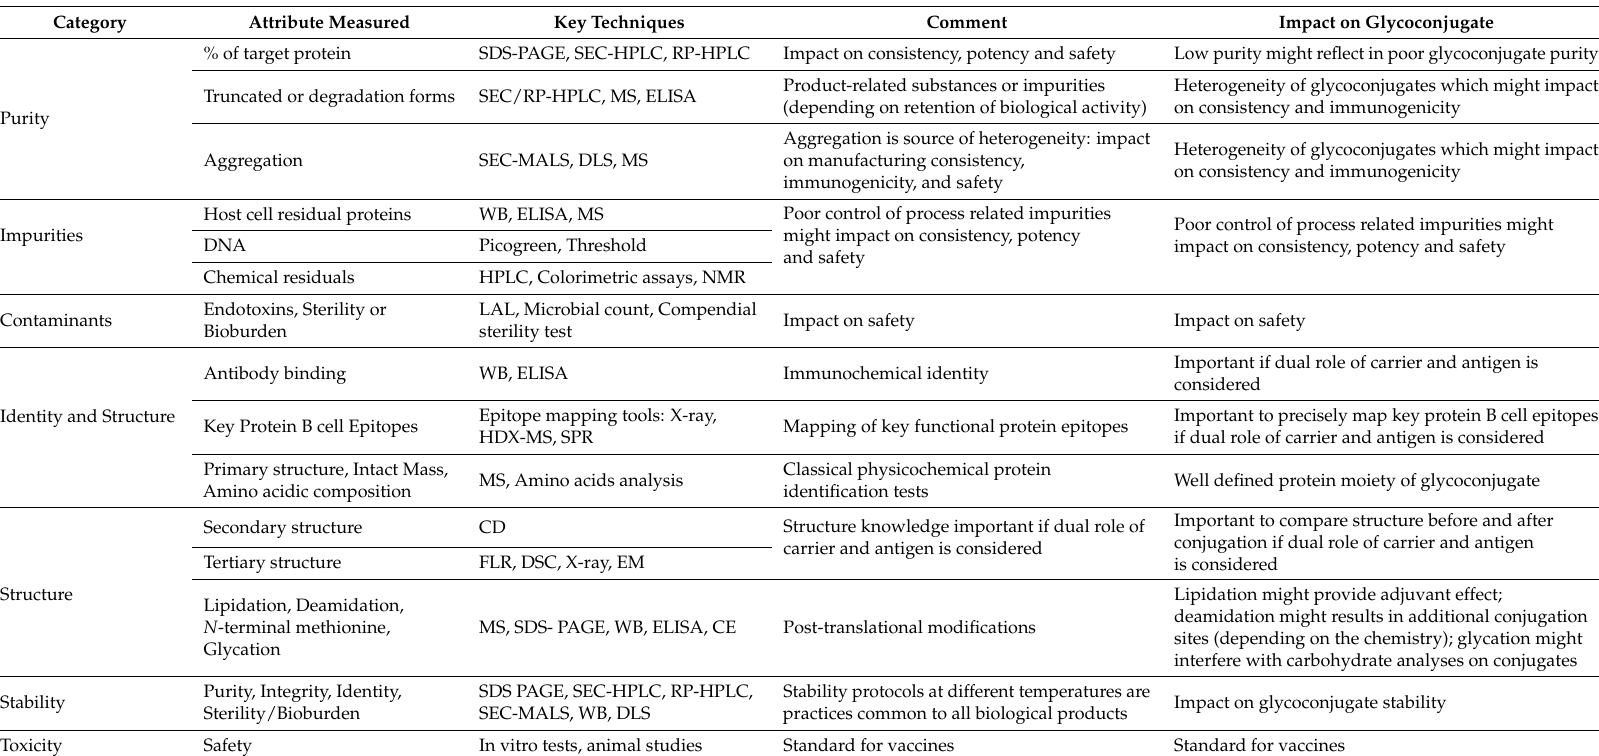
Table 1. Typical characterization panel for protein carriers before